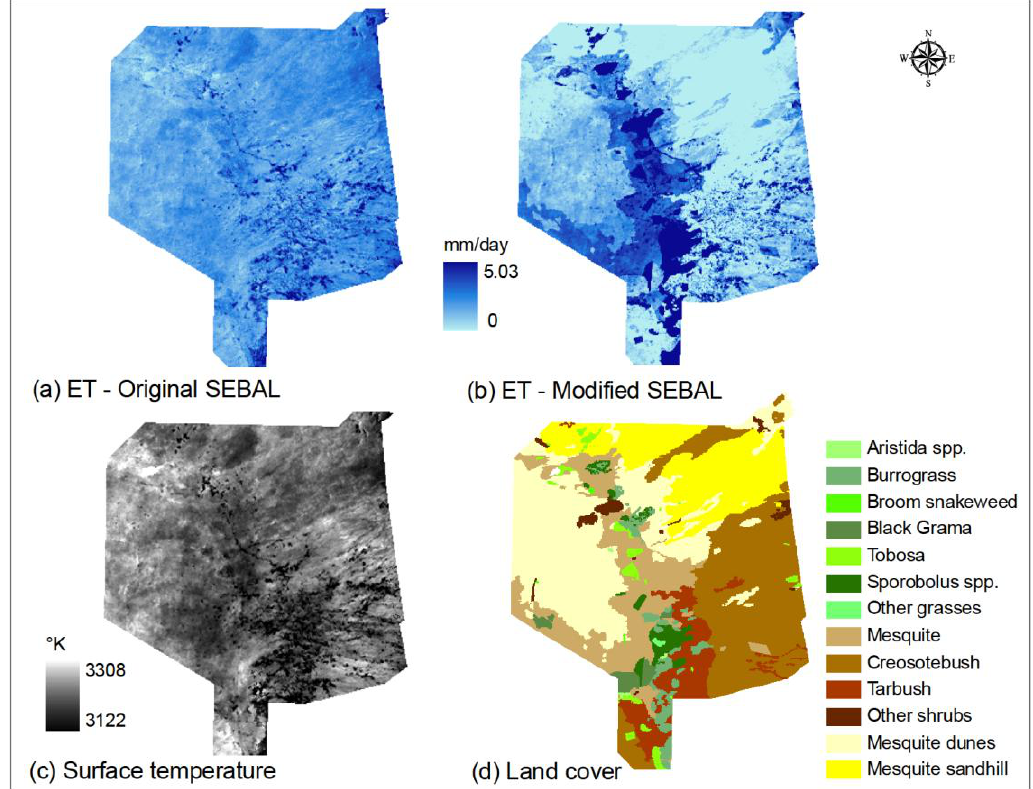
Figure 6. Final (a) non-reflectance corrected and (b) reflectance corrected ET (mm/day) maps, which show a pattern with (c) surface temperature and (d) land cover type,